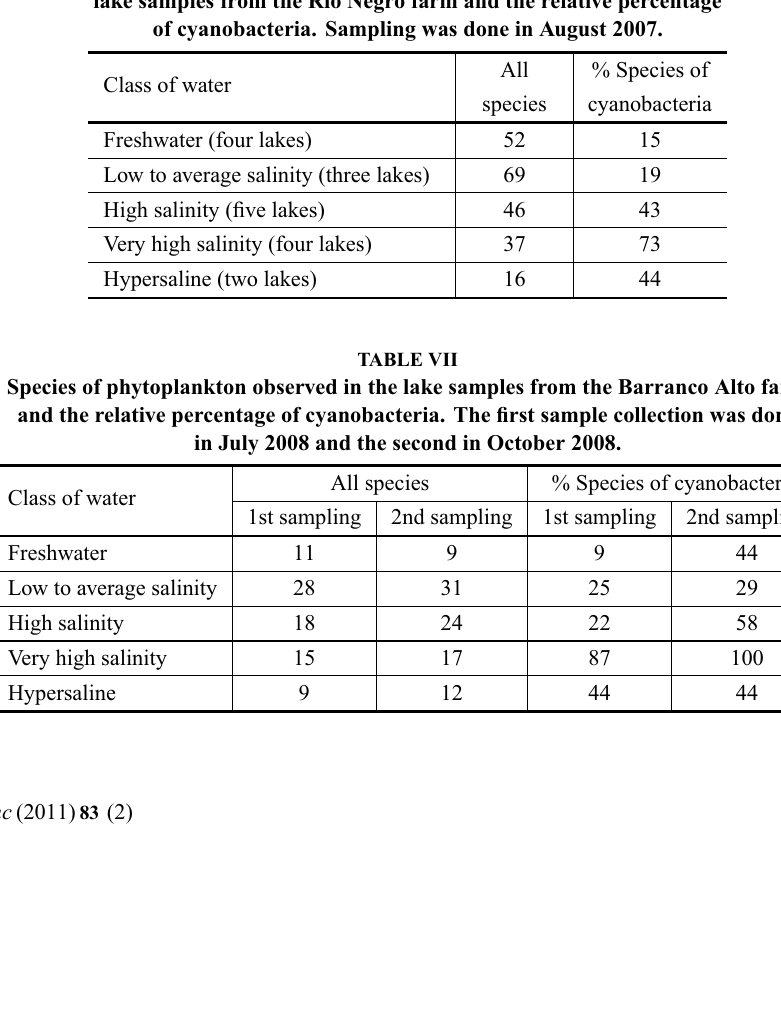
Euglenophyceae All the organisms